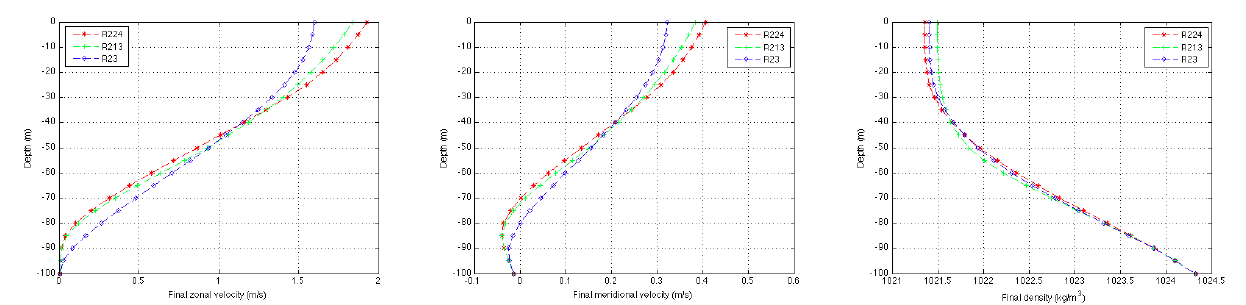
Fig. 3. Test 1: mixing-layer zonal velocity, meridional velocity and density profiles (from left to right) for models R 224, R 213 and R 23.